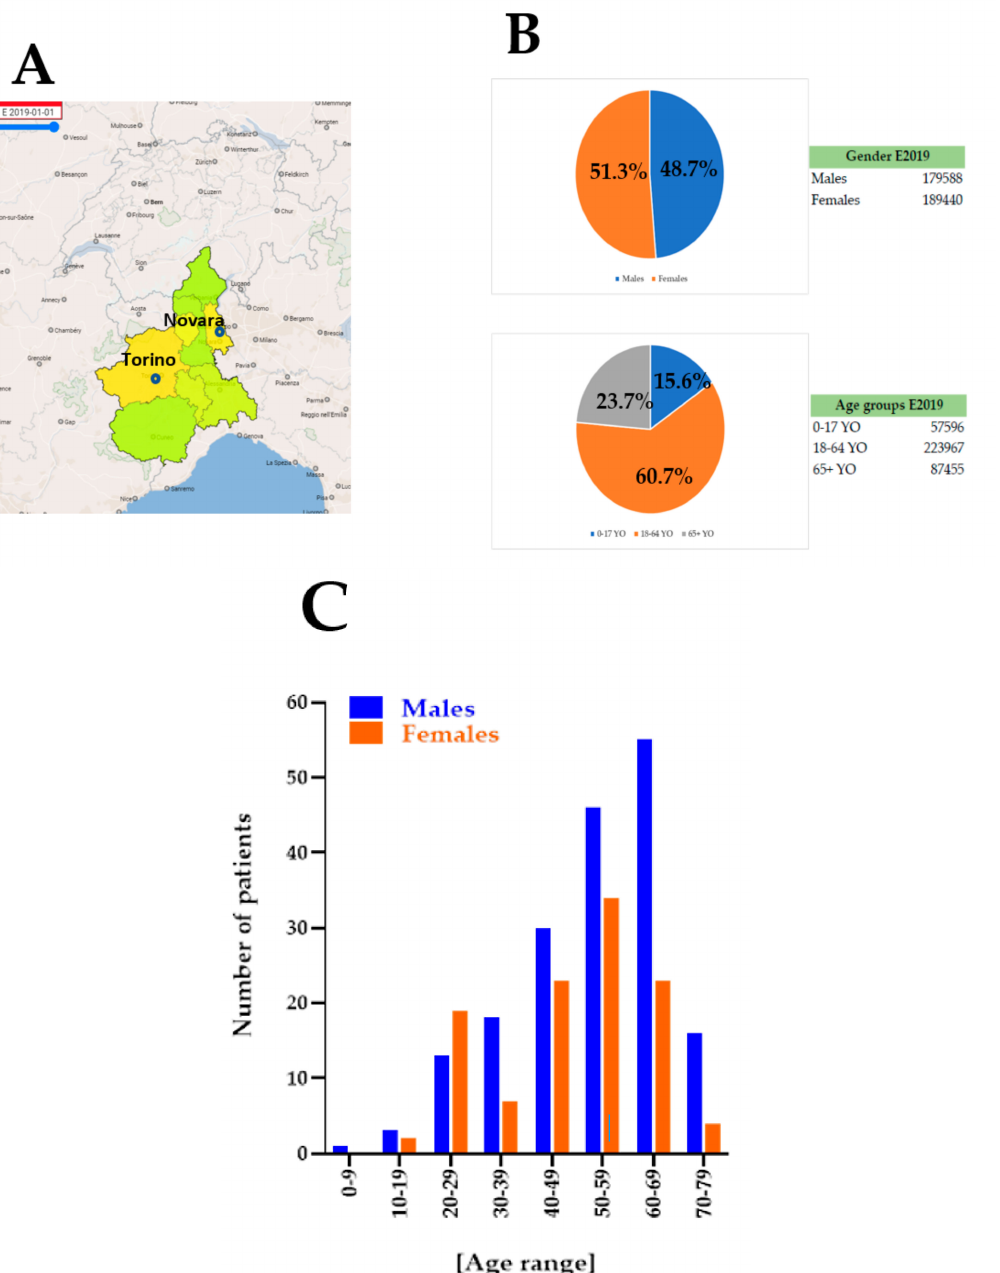
Figure 1. (A ), Major cities of Piedmont, Italy involved in the current study (Torino and Novara) where colors define the population density/km 2 (green: Low density and Yellow: high density). ( B ), Population structure of Piedmont according to Istituto Nazionale di Statistica Italia. ( C ), Age and sex distribution of the tested